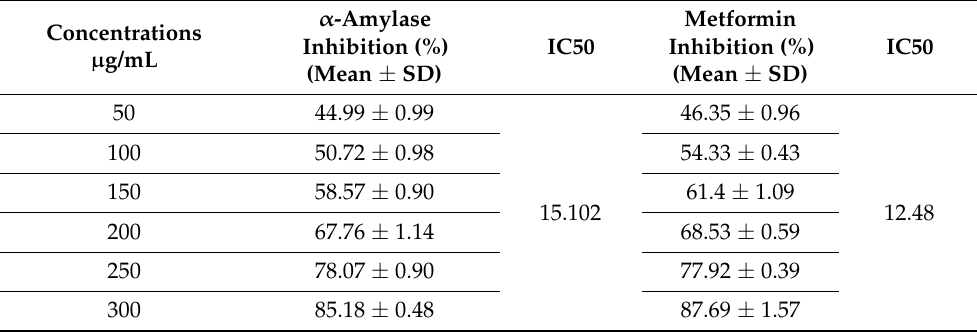
Table 3. α -Amylase inhibition (%) of ZnO NPs of aqueous fraction of L. edodes methanolic extract. The values are presented as the Mean ±